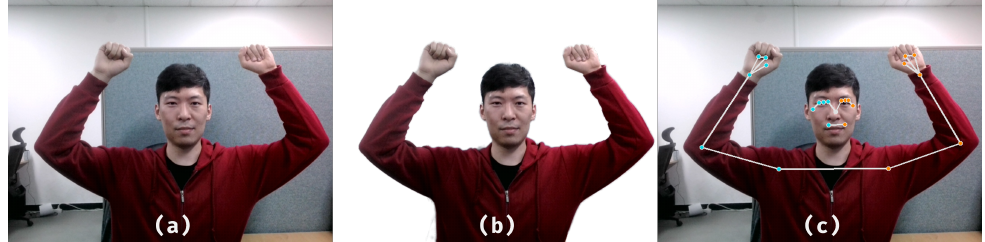
Figure 2. Results of RVM and MediaPipe Pose. ( a ) Original input frame of the upper body in 640 × 480 resolution. ( b ) RVM output without background. ( c ) Upper-body joints from MediaPipe